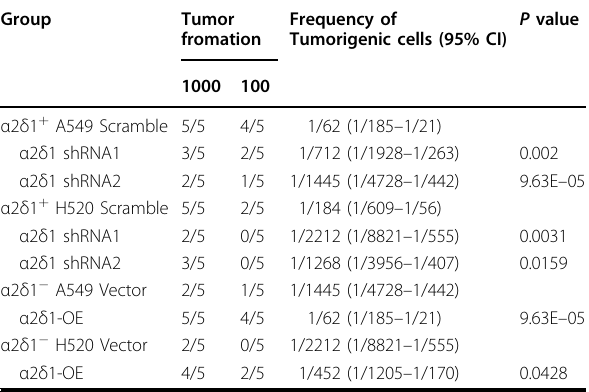
Table 2 The tumorigenicity of indicated cells with α 2 δ 1 knockdown or